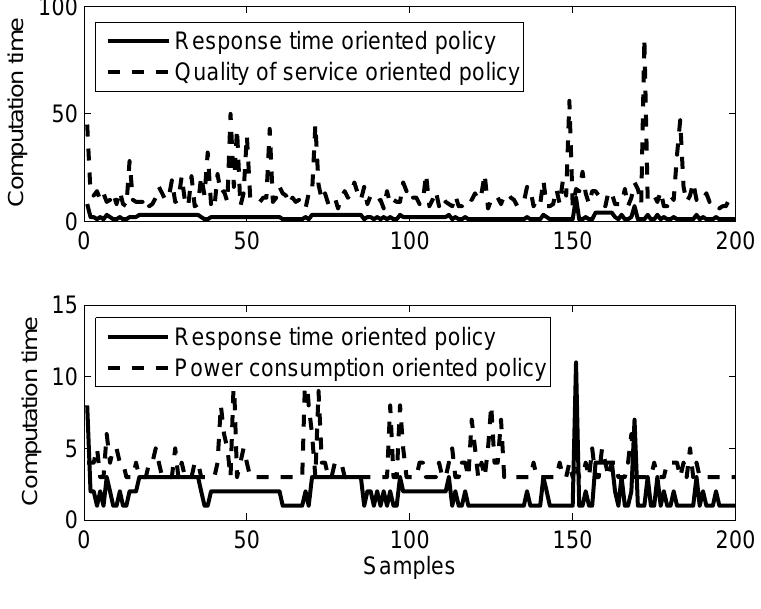
Figure 21. Comparison of computation (response) time.